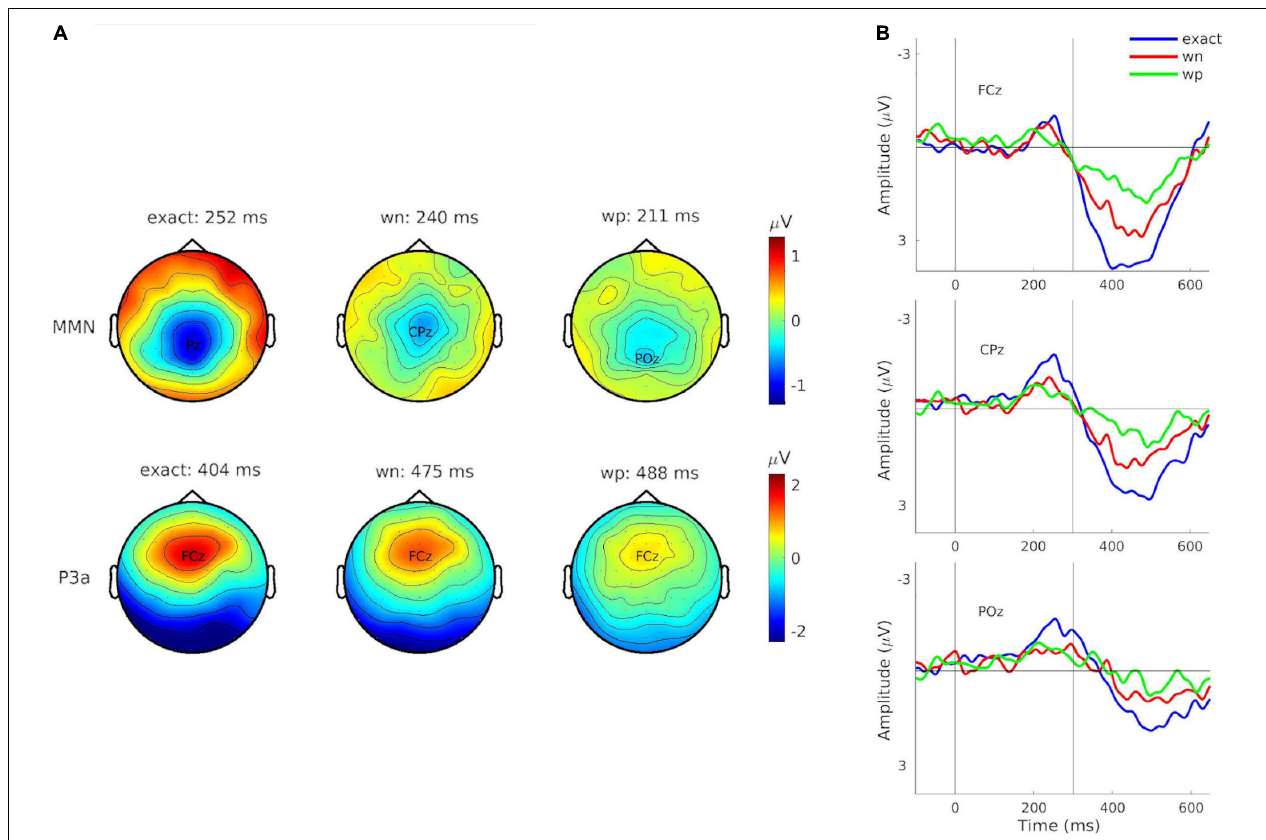
FIGURE 4 | (A) Potential topographies of the grand-averaged event-related potential (ERP) differences for combined train lengths 3, 6, and 12 for the components of interest mismatch negativity (MMN) ( top ) and P3a ( bottom ), depending on condition ( left : exact-repetition condition, exact; middle : white-noise condition, wn; right : wrong-pitch condition—wp). Topographies show the time point with the maximal amplitude deflections. Corresponding electrodes are highlighted. (B) Difference waves of the grand-averaged ERPs (deviants minus standards) for combined train lengths 3, 6, and 12 at electrodes FCz ( top ), CPz ( middle ), and POz ( bottom ). Conditions are indicated by different colors (exact: blue, wn: red, and wp: green). Vertical solid lines indicate the pattern onset at 0 ms and the pattern offset at 300